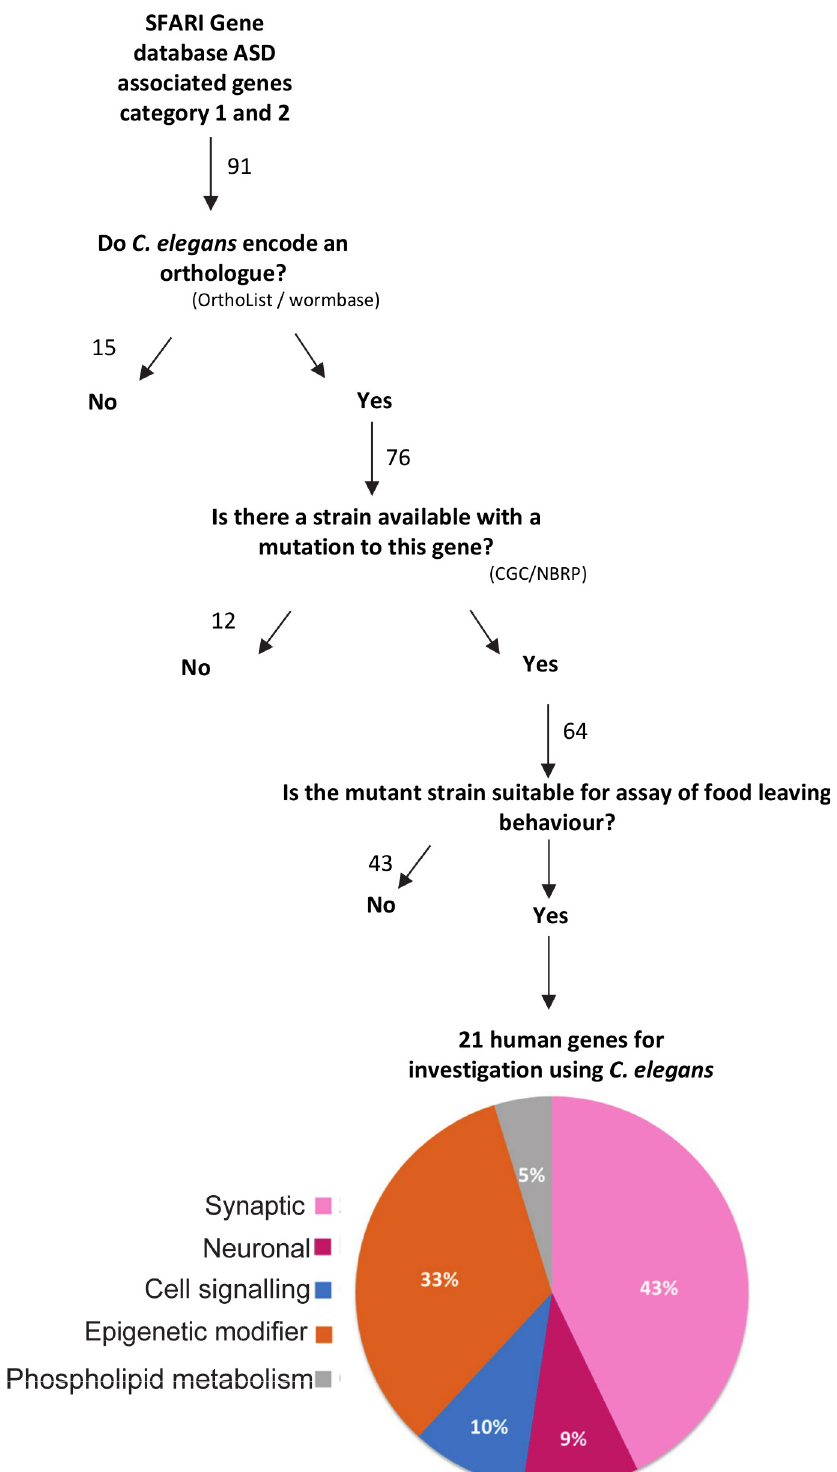
Fig 1. Prioritisation and categorization of the C . elegans orthologues of prioritised human ASD associated genes. High confidence ASD associated genes in category 1 and 2 in SFARI Gene Archive were input. The pipeline selects human genes which have an orthologue in C . elegans which can be studied in an available mutant strain which is neither lethal, sterile or uncoordinated. In brackets are the resources used for analysis. CGC– Caenorhabditis Genetics